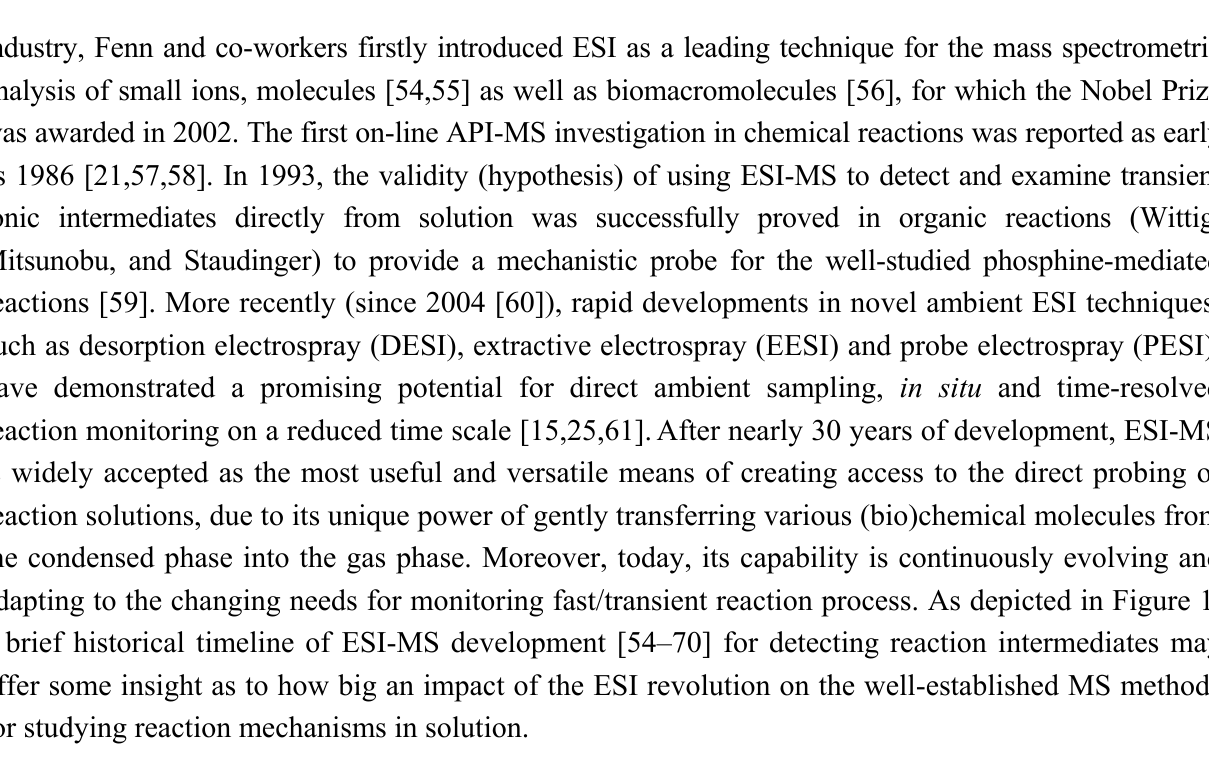
Figure 1. A historical timeline showcasing the significant events and milestones [54–70] in the development of ESI-MS for detection of reaction